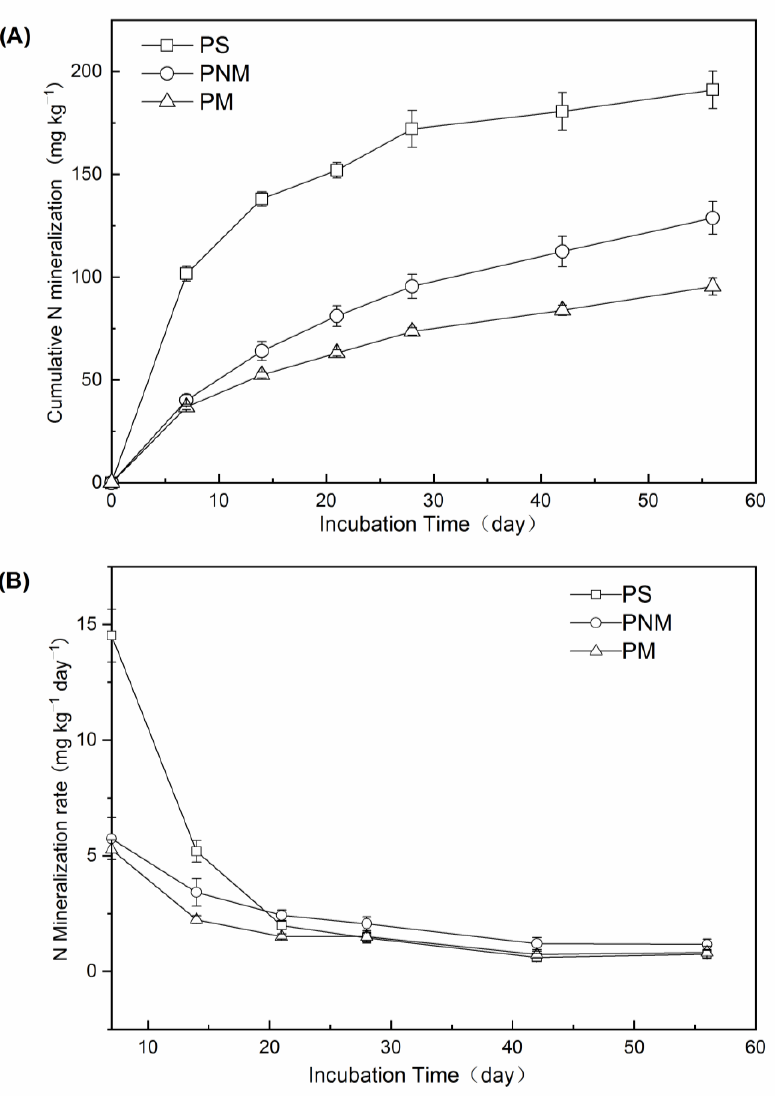
Figure 3. The cumulative nitrogen mineralization ( A ) and mineralization rate ( B ) for the paddy field, P. plantation without mulching and P. plantation with mulching sites. PS, rice paddy soil; PNM, Phyllostachys praecox plantation without mulching; PM, P. praecox plantation with mulching. Bars are the mean ± standard error ( n = 3).